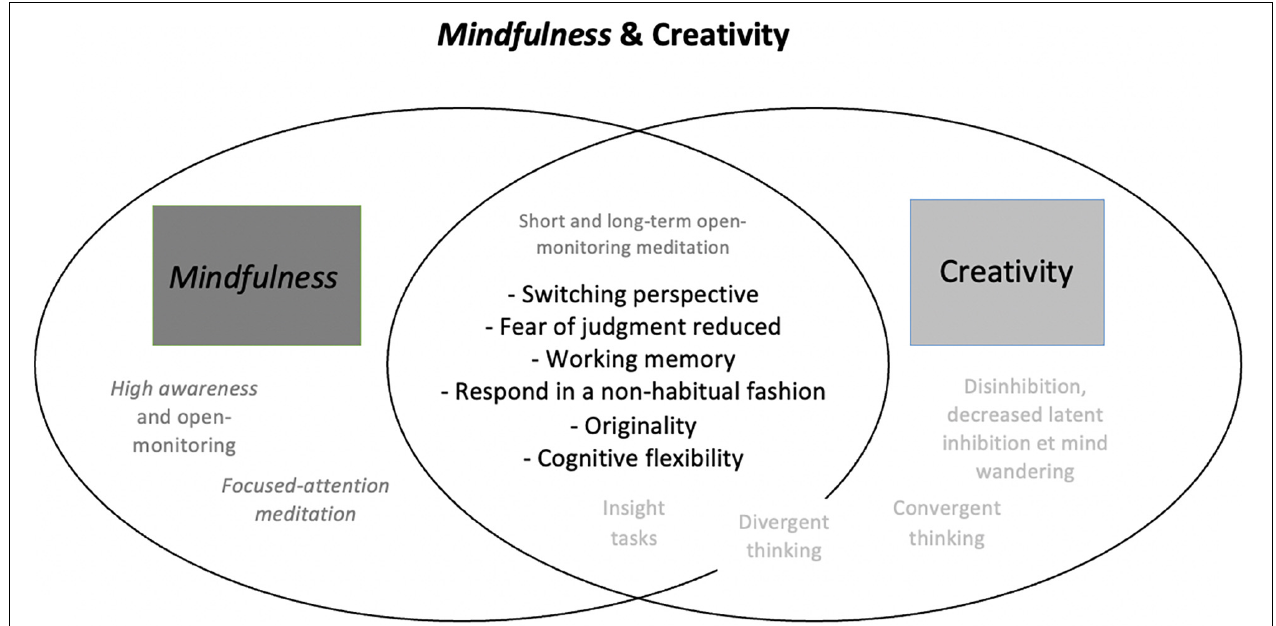
FIGURE 1 | Model of the link between mindfulness and creativity. Schematization from Lebuda et al.